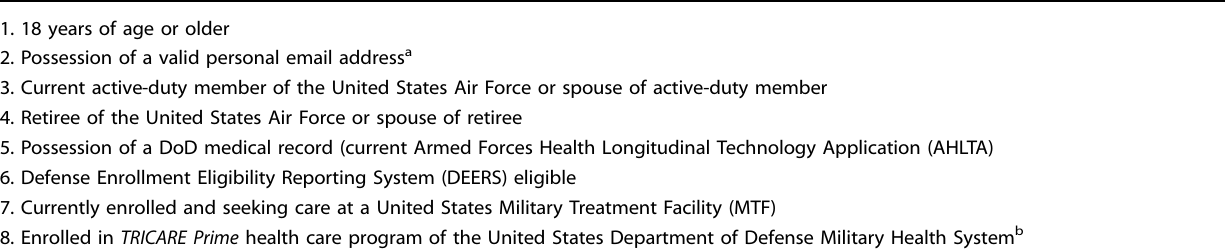
Table 1. CPMC Air Force Clinical Utility Study, current eligibility criteria